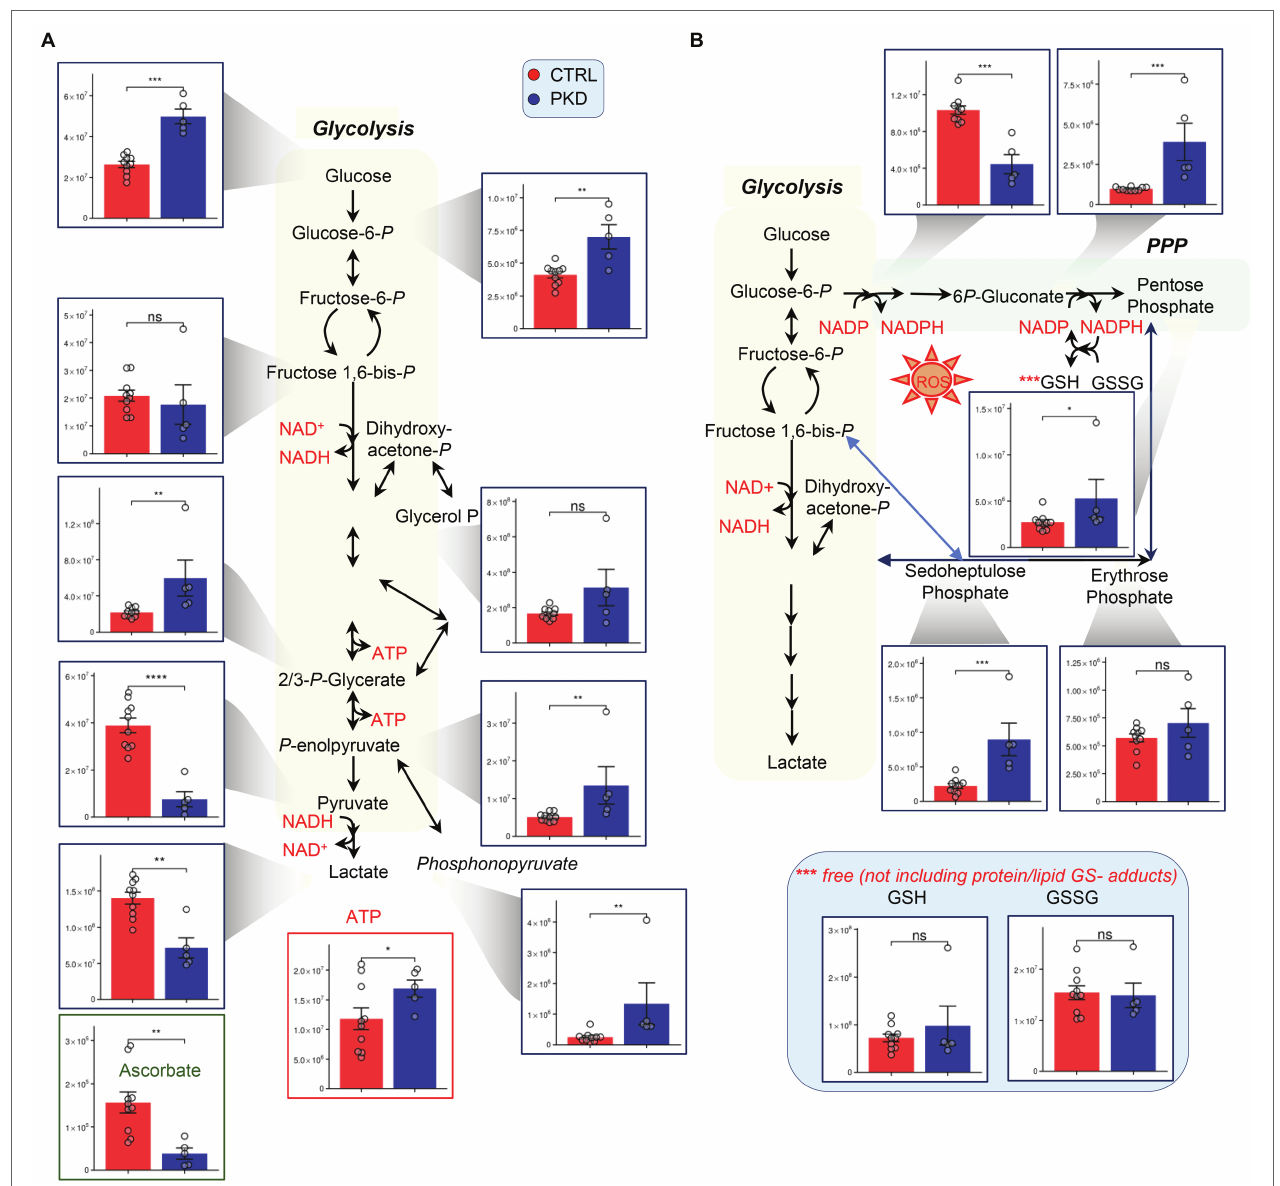
FIGURE 2 | Pyruvate kinase deficiency reprograms (A) glycolysis and (B) the pentose phosphate pathway (PPP). Y-axes represent peak area (arbitrary units). Asterisks indicate significant results, error bars represent ±SEM (unpaired t -test, two-tailed distribution, * p < 0.05, ** p < 0.01, *** p < 0.001, and **** p <